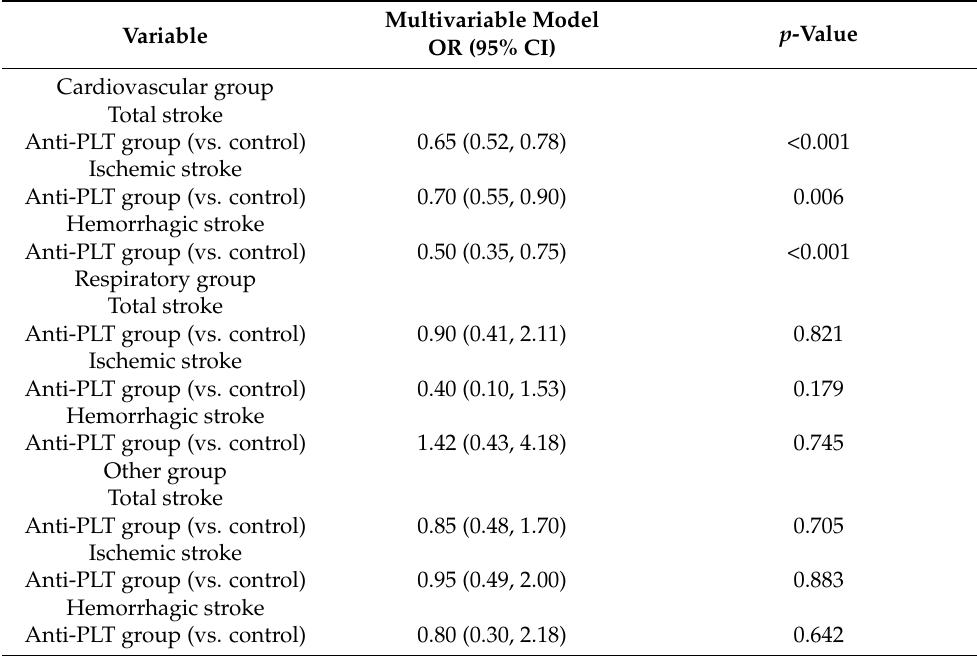
Table 3. Subgroup analyses according to main diagnosis at ECMO therapy considering ECMO type.